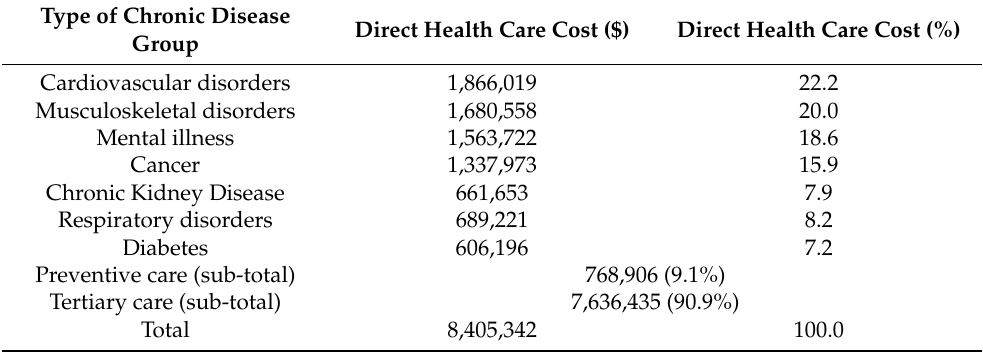
Table 5. Additional direct health care costs incurred due to LHL (by type of chronic disease group) in the Blacktown LGA (Domain 9).